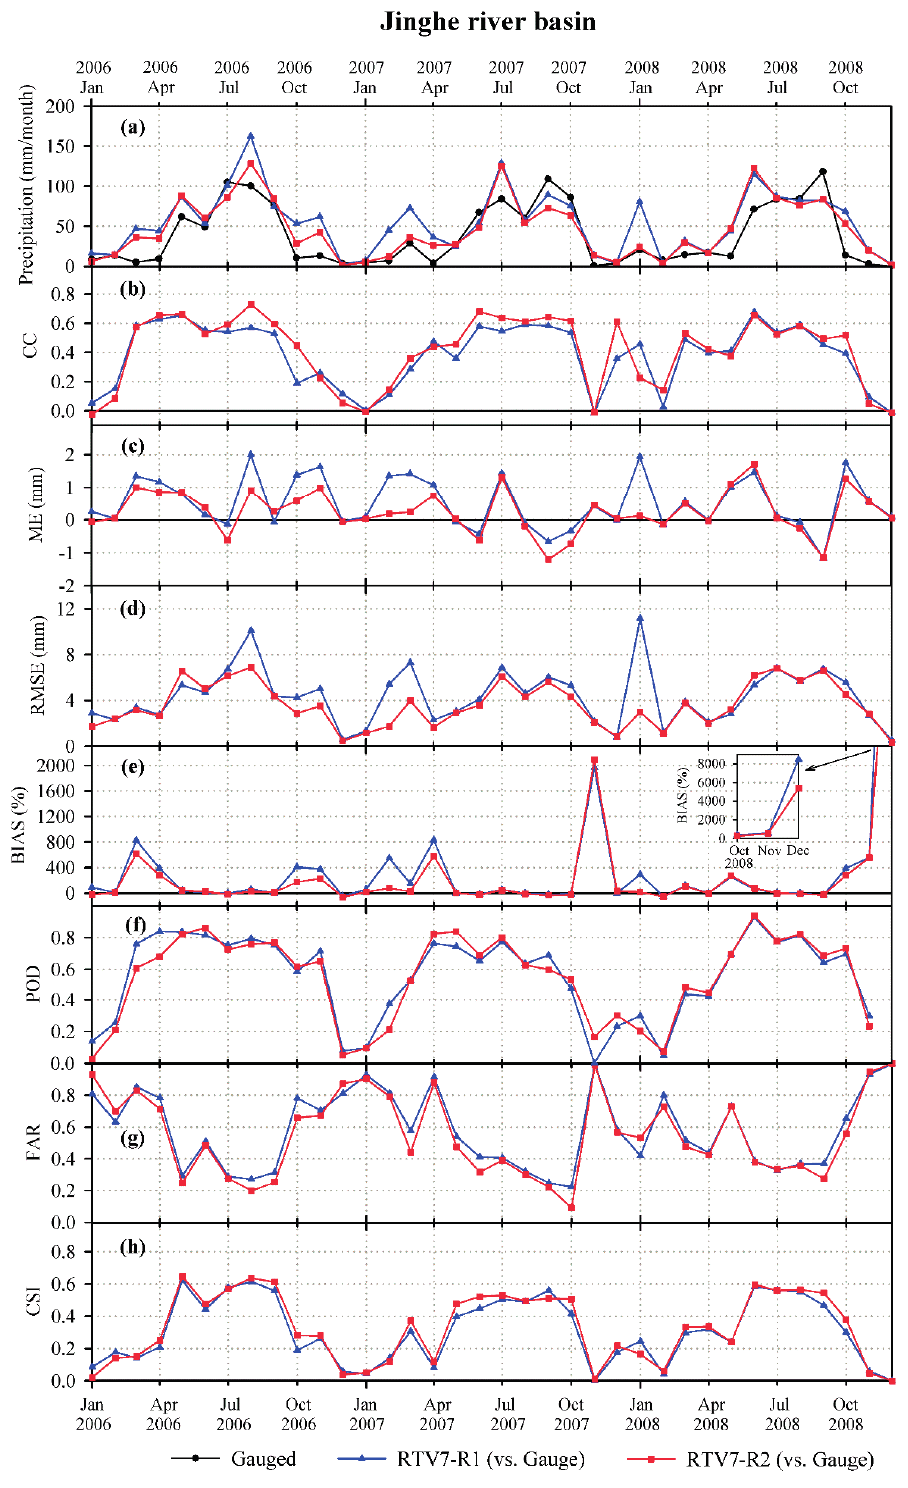
Figure 3. ( a ) Average monthly precipitation time series and ( b – h ) monthly variations of statistical indices of daily original and reprocessed 3B42RTV7 versus gauge observation for the 32 selected grid boxes: (b) correlation coefficient; (c) mean error; (d) root-mean-square error; (e) relative bias; (f) probability of detection; (g) false alarm ratio; and (h) critical success